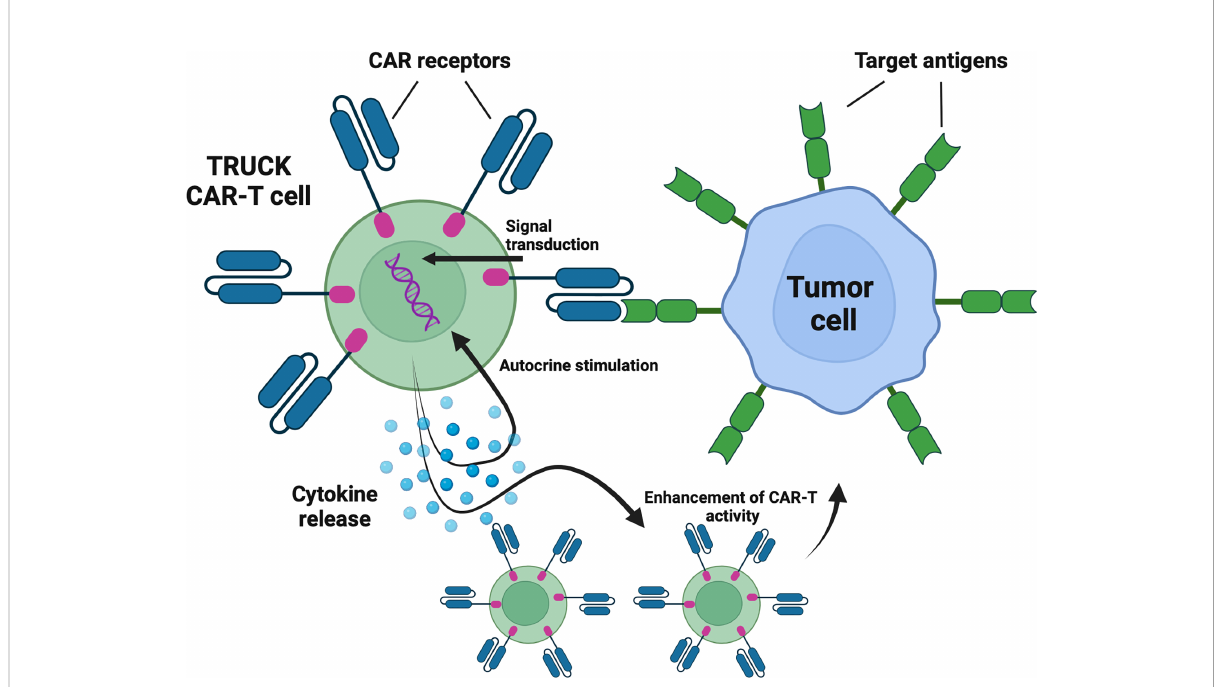
FIGURE 3 TRUCKs – cytokine-expressing CAR-T cells. TRUCKs are next-generation CAR-T cells engineered to express certain cytokines to augment CAR- T cells ’ antitumor ef fi cacy, improve their persistence, and alte tumor microenvironment characteristics. Following antigen recognition, in addition to cytotoxic activity, the engineered cells release selected cytokines. Depending on the type, cytokines may promote the proliferation and survival of CAR-T cells and act as chemoattractants and enhancers of antitumor activity. Created with